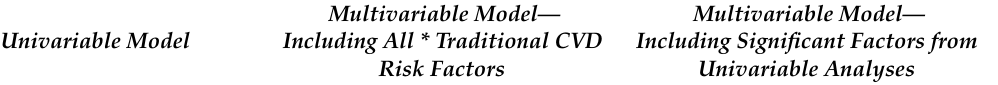
Table 5. Association of risk factors for cardiovascular disease (CV) with development of a future CV event (after the index date 1 ) in individuals prior to the onset of RA ( n = 494), and disease related factors at index date, adjusted for age, sex, and additional treatments (for hypertension, lipid-lowering treatment, or for diabetes mellitus) after the index date. Multivariable Model— Multivariable Model— Including Significant Factors from Univariable Model Including All * Traditional CVD Univariable Analyses Risk Factors HR HR HR p -Value p -Value p -Value (95% CI) (95% CI) (95% CI)